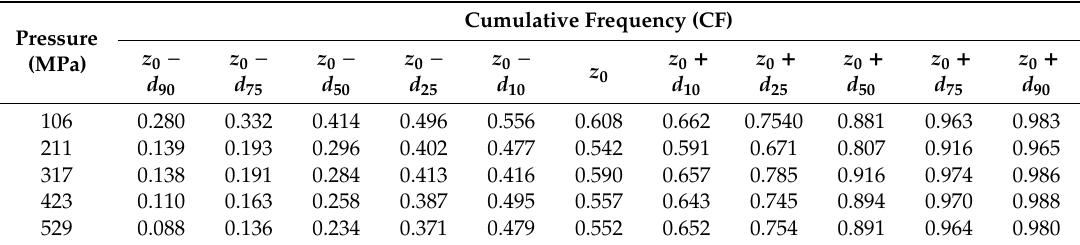
Table 3. Cumulative frequency of contact surfaces of each height under high stress of clay soil.